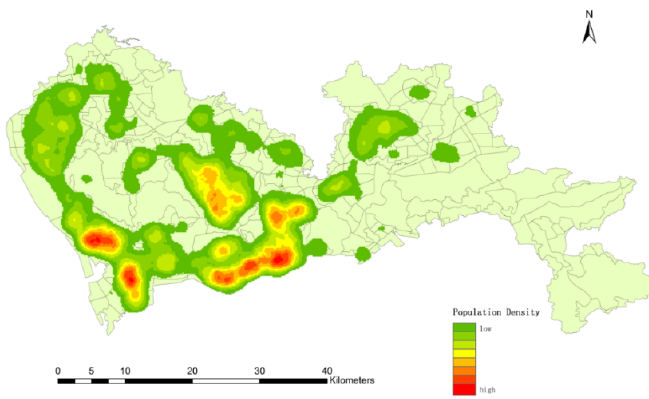
Figure 5. Distribution pattern of human activities at night based on mobile big data